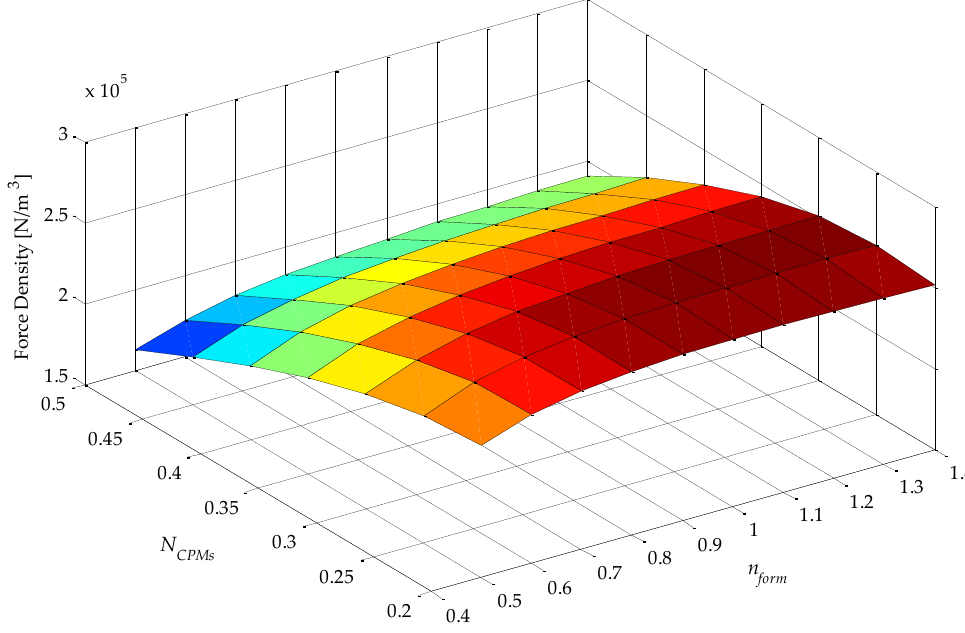
Figure 13. 3D graph with results of force density of the coupled design for two parametric variables: N CPMs and n form . Results for τ r / τ p = 0.75 and N PMi = 0.60.